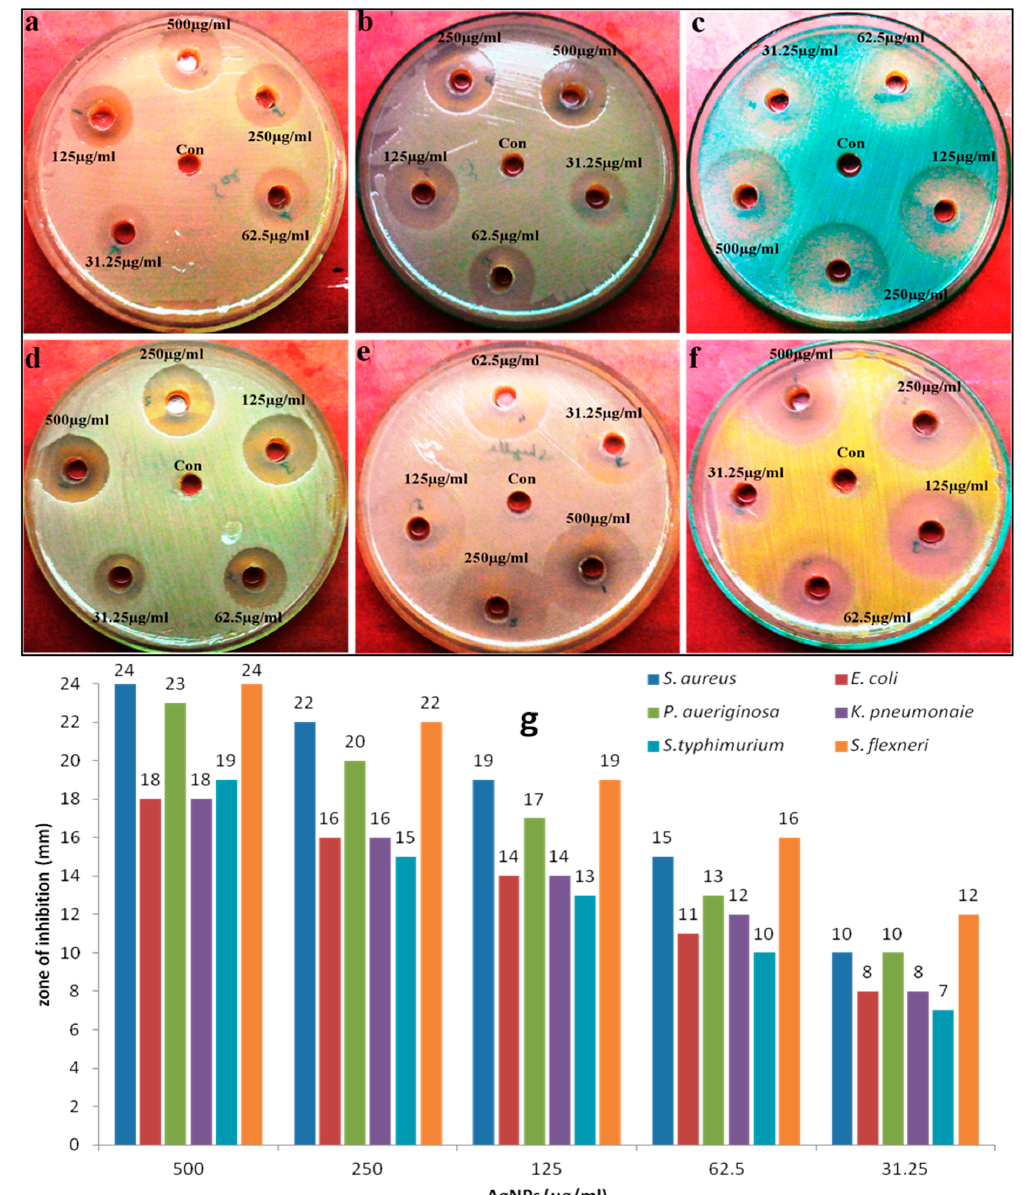
Figure 6. Antibacterial activity of mycosynthesized AgNPs at different concentrations evaluated by agar well diffusion method against different pathogenic bacteria: ( a ) E. coli , ( b ) K. pneomonaie , ( c ) P. aeruginosa , ( d ) S. typhimurium , ( e ) S. flexneri , and ( f ) S. aureus . Panel ( g ) represents the zone of inhibition (in mm) at different concentrations of AgNPs.